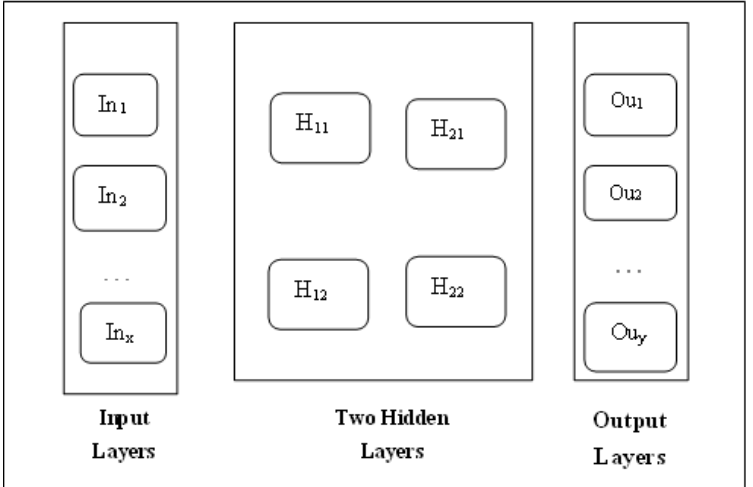
Figure 4. The proposed adaptive ANN structure.